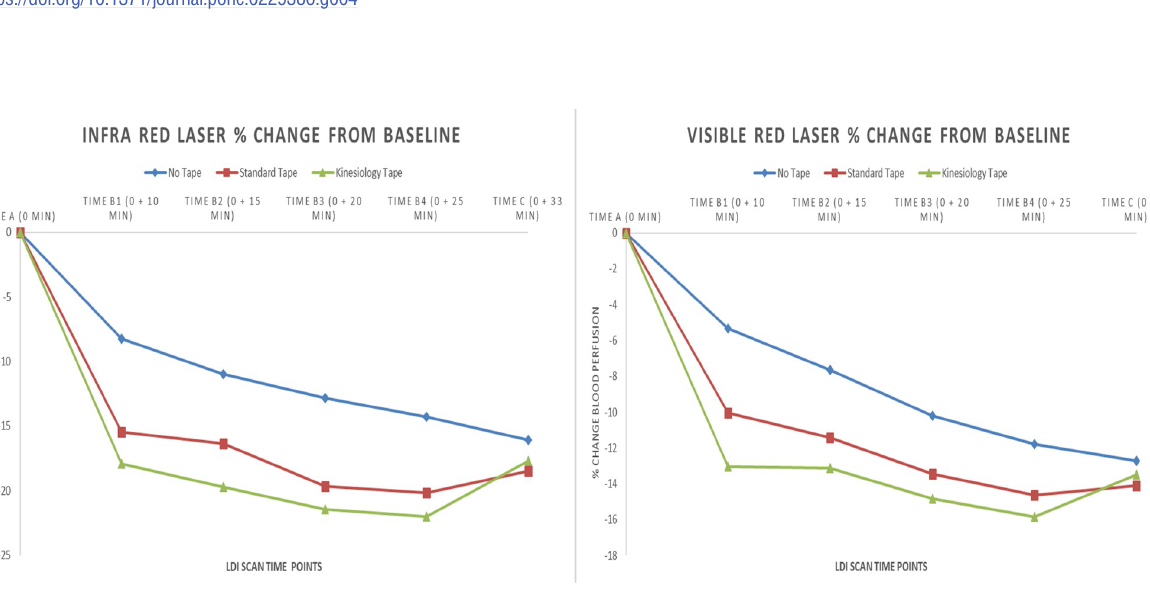
PLOS ONE | https://doi.org/10.1371/journal.pone.0229386 February 21,